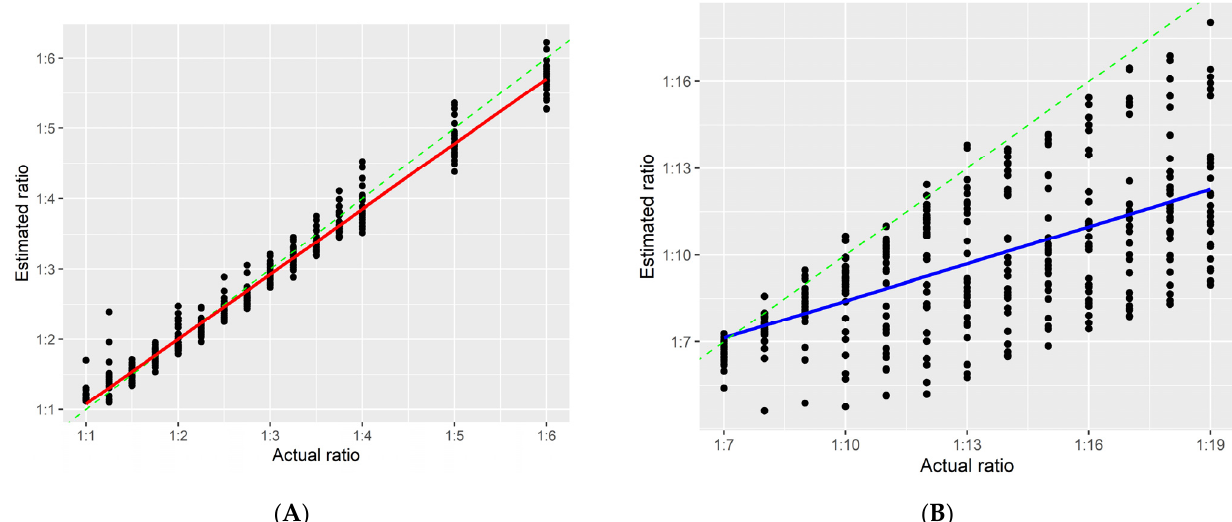
Figure 7. The actual ratios (x-axis) of 825 in silico mixtures against their estimated ratios (y-axis). ( A ) and ( B ) show mixture ratios of 1:1 to 1:6, and 1:7 to 1:19, respectively. The green dashed line represents the diagonal line of the scatterplots, and the red and blue solid lines are linear regression lines. The red line was intercepted on the y-axis at 0.1522, and the slope was 0.9251, with a correlation coefficient R 2 = 0.9798 ( p < 0.05). The corresponding values for the blue line were 4.1315, 0.4282, and 0.3964 ( p < 0.05), respectively.